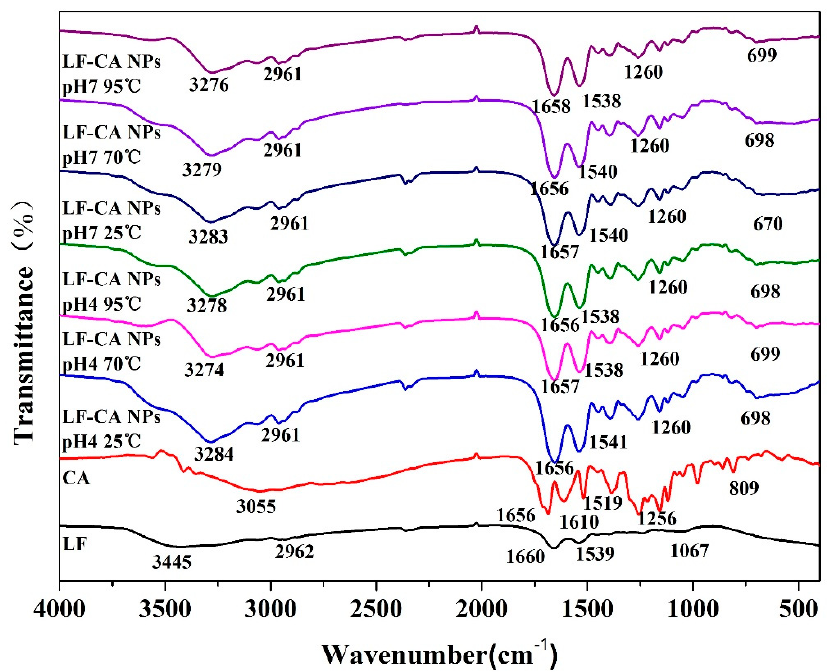
Figure 5. FTIR characteristics of LF-CA NPs, LF NPs, and CA.